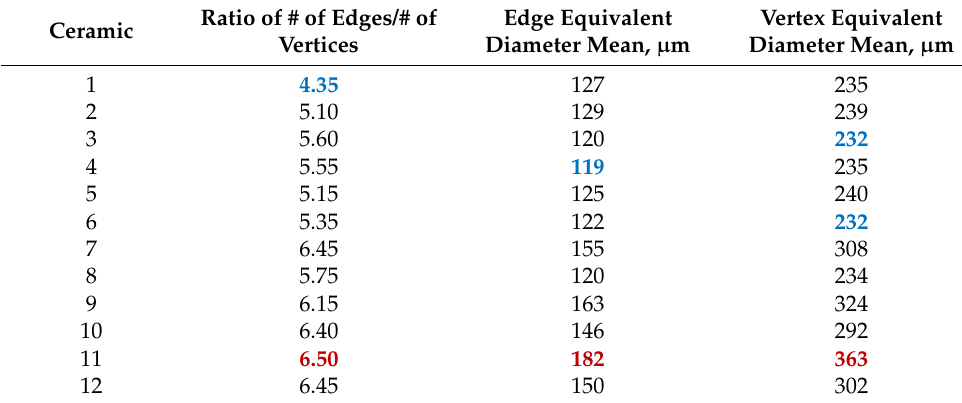
Table 7. Significant ( p < 0.05) pore network variables from Open PNM. Ceramic